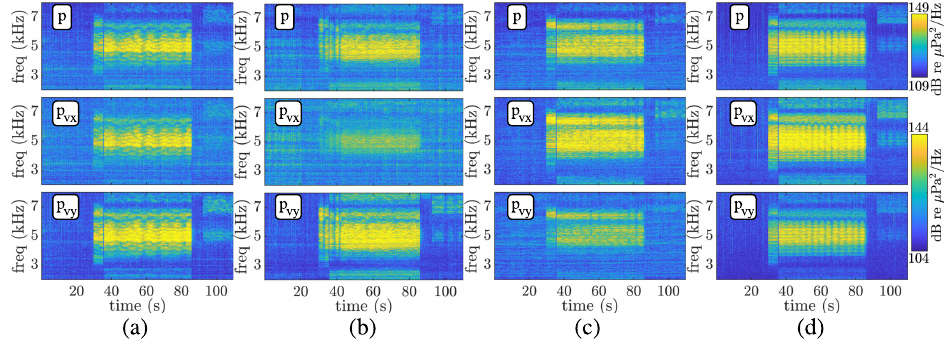
Figure 5. EMSO’21 spectrogram for pressure ( p ) and pressure-equivalent particle velocity ( p vx and p vy ) during stations 3, 7, 12, and 14, from ( a – d ),